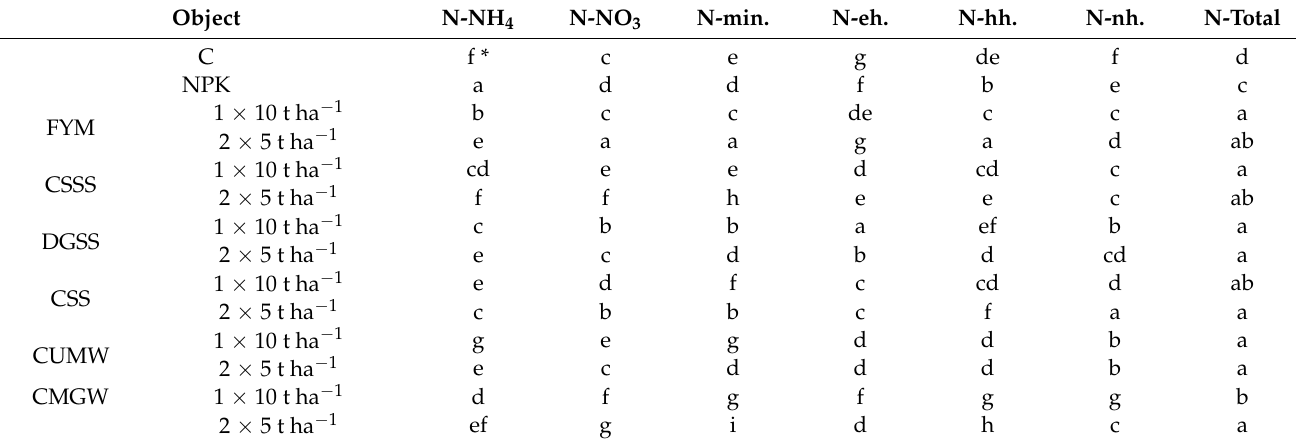
Figure 1. Content of N-total in soil—mean ± SE (a—2 × 5 t ha − 1 , b—1 × 10 t ha − 1 ). Table 2. Statistically significant differences the N content in the determined fractions (one-way-Anova). Object N-NH 4 N-NO 3 N-min. N-eh. N-hh. N-nh.